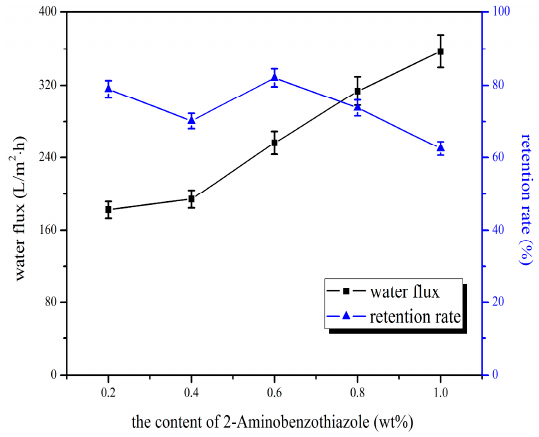
Figure 1. Effect of 2-aminobenzothiazole dosage on water flux and retention rate of bovine serum albumin (BSA).